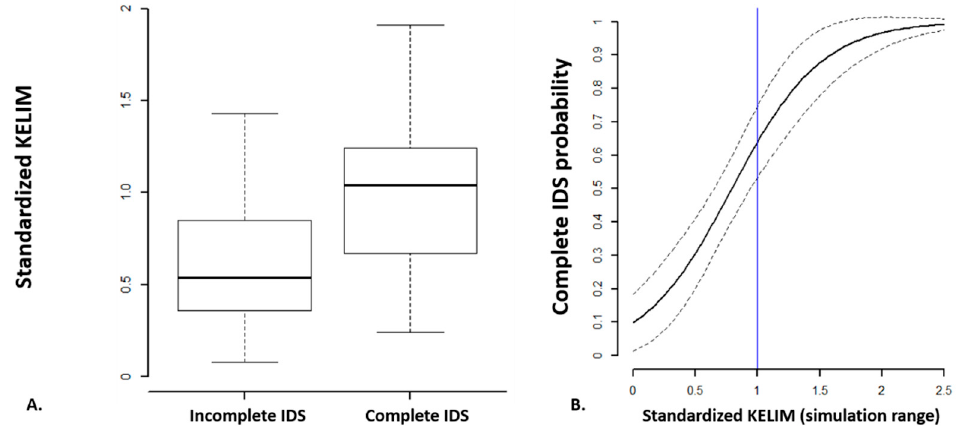
Figure 3. ( A ) Standardized KELIM distribution across surgery outcome. ( B ) Logistic regression curve regarding the probability of complete surgery according to continuous std KELIM values (Adjusted from You et al., Clin Cancer Res 2020 [27]).